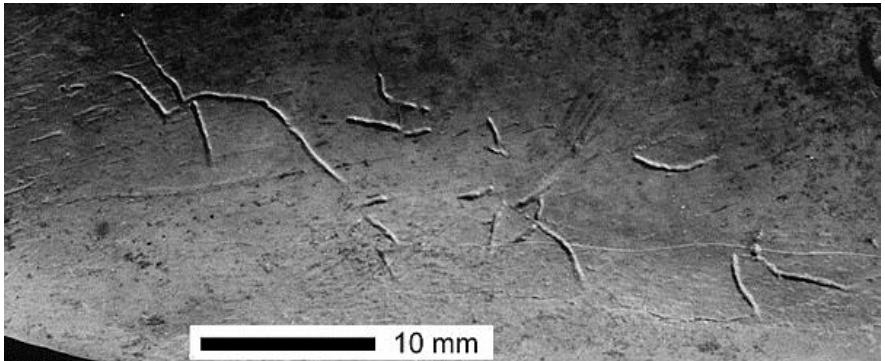
Figure 12. Taphonomic (natural) marks on a horse humerus fragment from the Shiyu site, central China, that have been interpreted as depicting two hunting scenes, c. 28,000 years